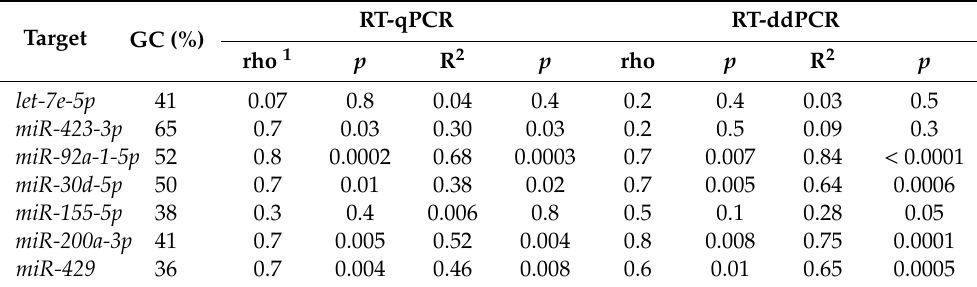
Table 3. miRNA guanine-cytosine (GC) content and results on pairwise Spearman’s rank and regression analyses by comparing RT-qPCR and RT-ddPCR of formalin- and Bouin’s-fixed samples.